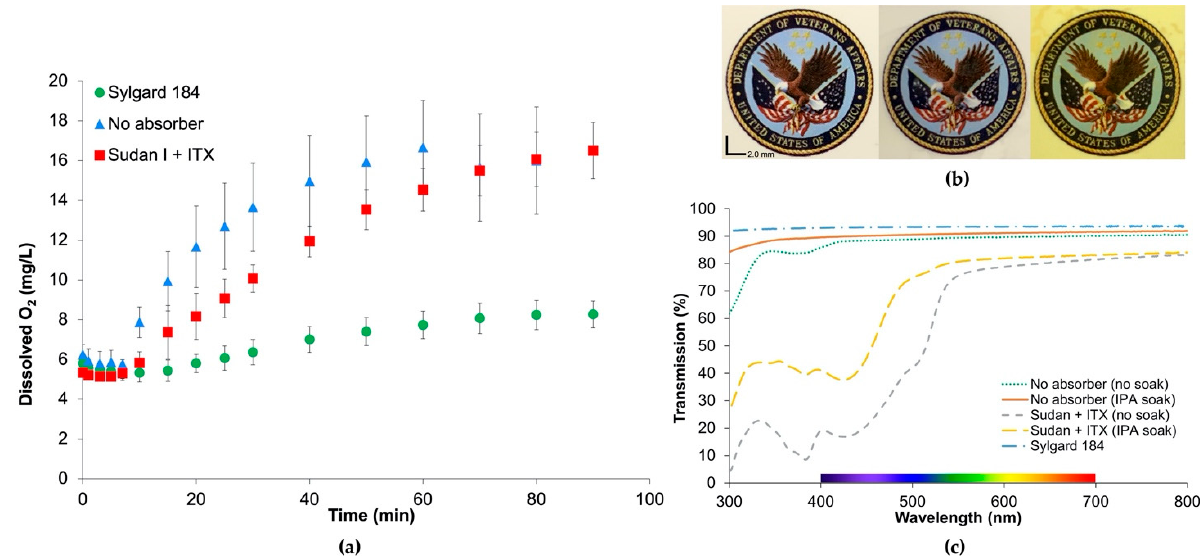
Figure 7. ( a ) Plot of dissolved oxygen in DI water through a 100 µ m thick film, demonstrating the permeability of the 3D-printed resin relative to Sylgard 184. Error bars represent the standard error of mean ( n = 3); ( b ) images of 100 µ m Sylgard 184 film ( left ), no absorber film ( middle ), and Sudan + ITX film ( right ) laid over an image with text and color demonstrating optical clarity of resin; ( c ) transmission spectrum of 100 µm film of Sylgard 184, no absorber films before and after soaking in isopropyl alcohol (IPA) to remove extractables, and Sudan + ITX films before and after soaking in IPA.